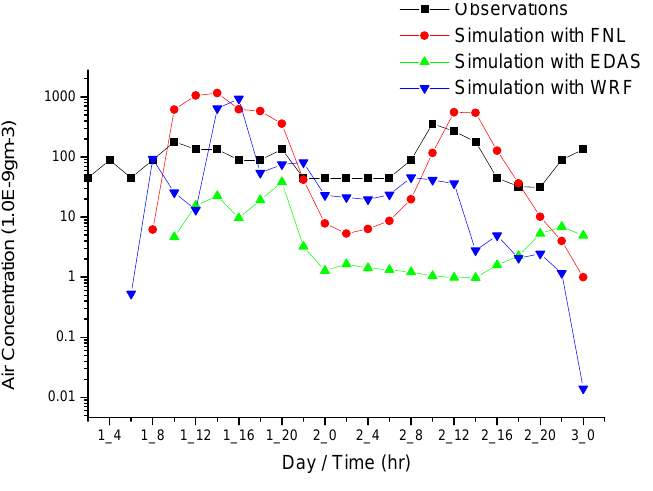
Figure 10. Diurnal variation of observed and simulated SO monitoring